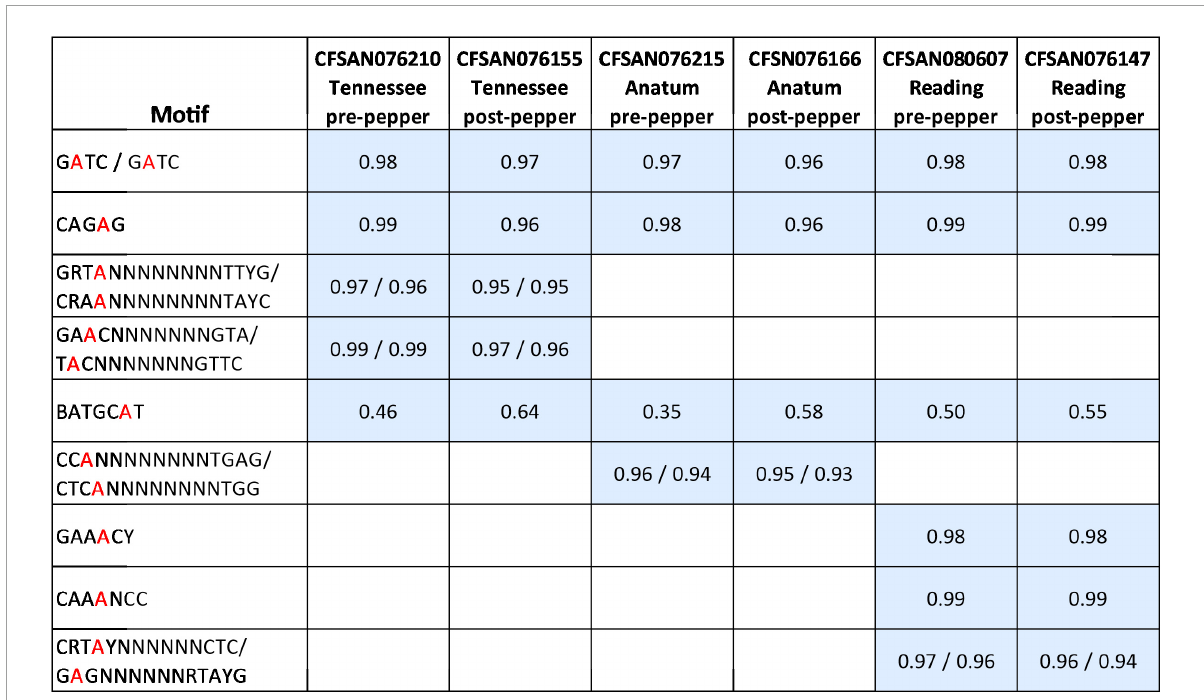
FIGURE1 Methylated motifs identified in pre- and post-pepper isolates of three S. enterica serovars, with the percentage of methylation of each motif shown in gray squares (number of methylated motifs/total number of motifs present in genome). BATGCAT is the only motif which is partially methylated (i.e., fewer than 95% of sites are methylated throughout the genome).